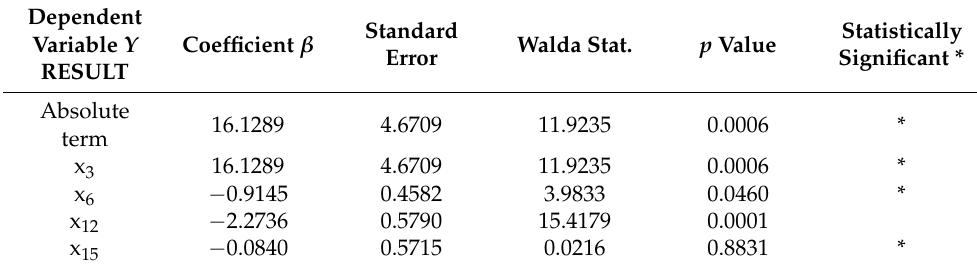
Table 4. Parameter estimates for the logit model—four explanatory variables.